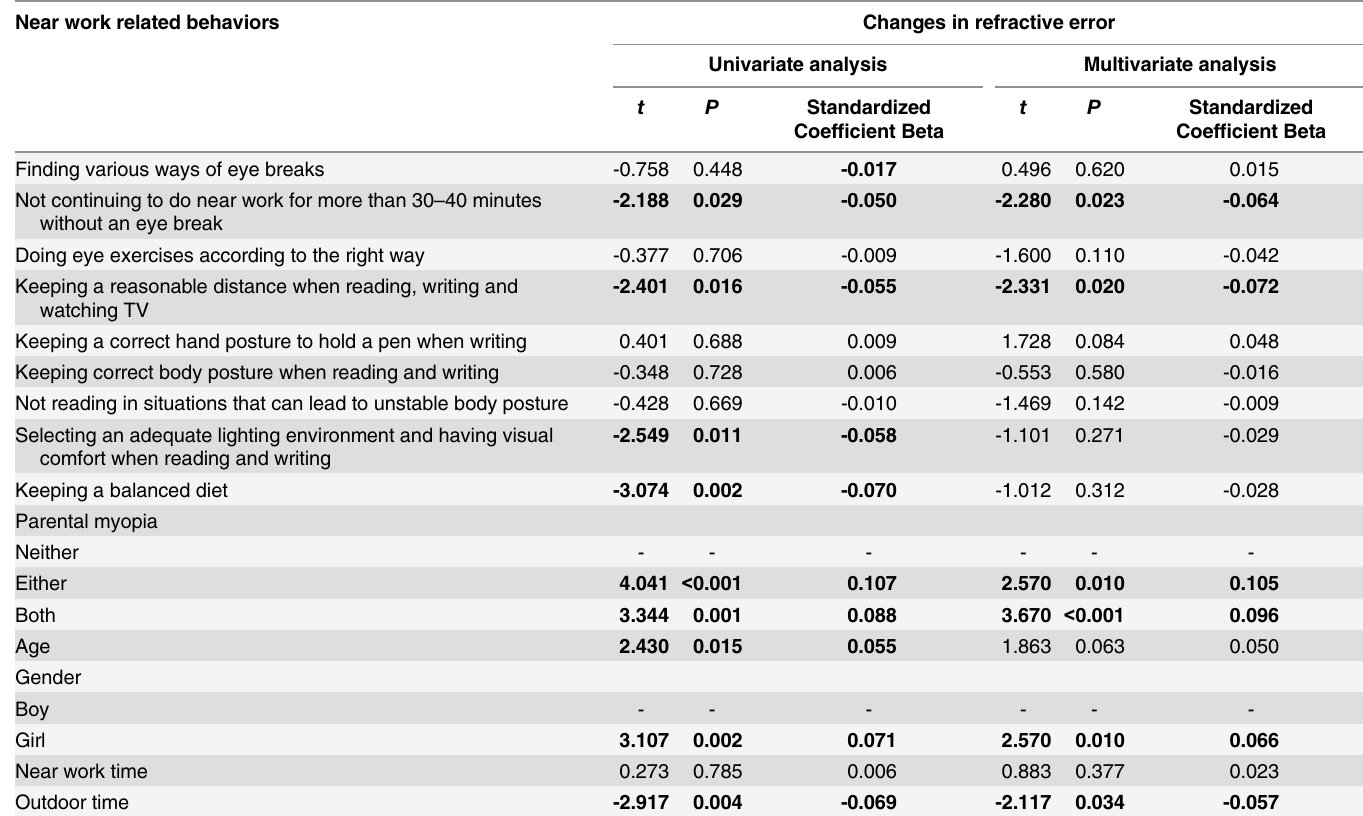
Table 5. Near work related behaviors associated with changes in refractive error within one year in students of grades 1 to 4 in